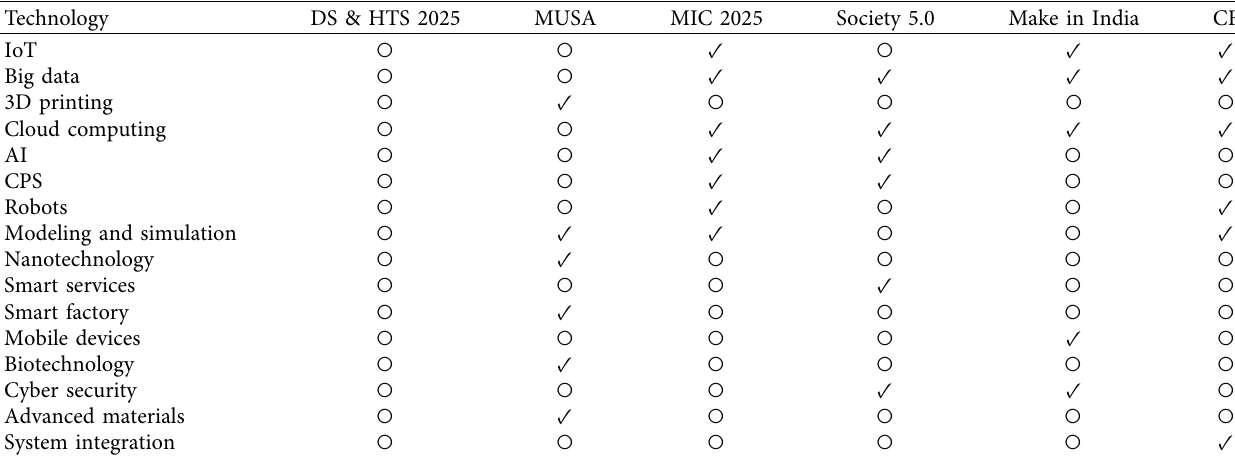
Table 9: Technology focus of industry 4.0 initiatives.